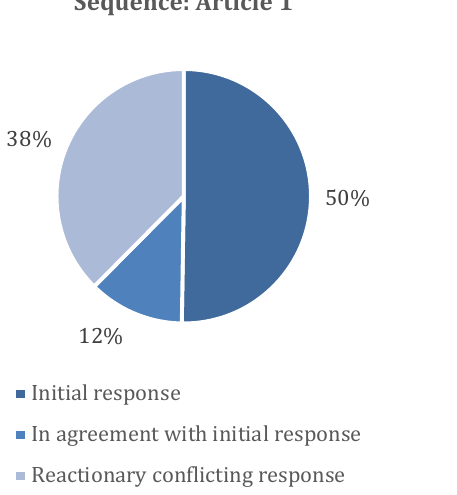
Figure 2: Sequence of responses to Articles 1 and 2